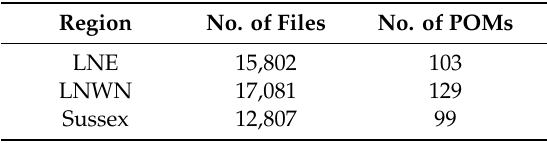
Table 1. Files present in the dataset for each